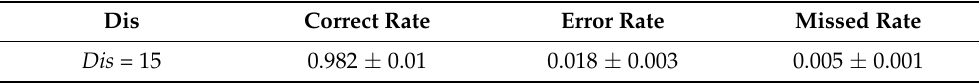
Table 2. Experimental result.